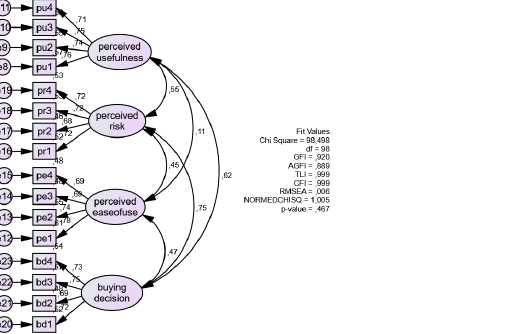
Fig. 3. The result of Structural Equation Modelling using Analysis of Moments Structure